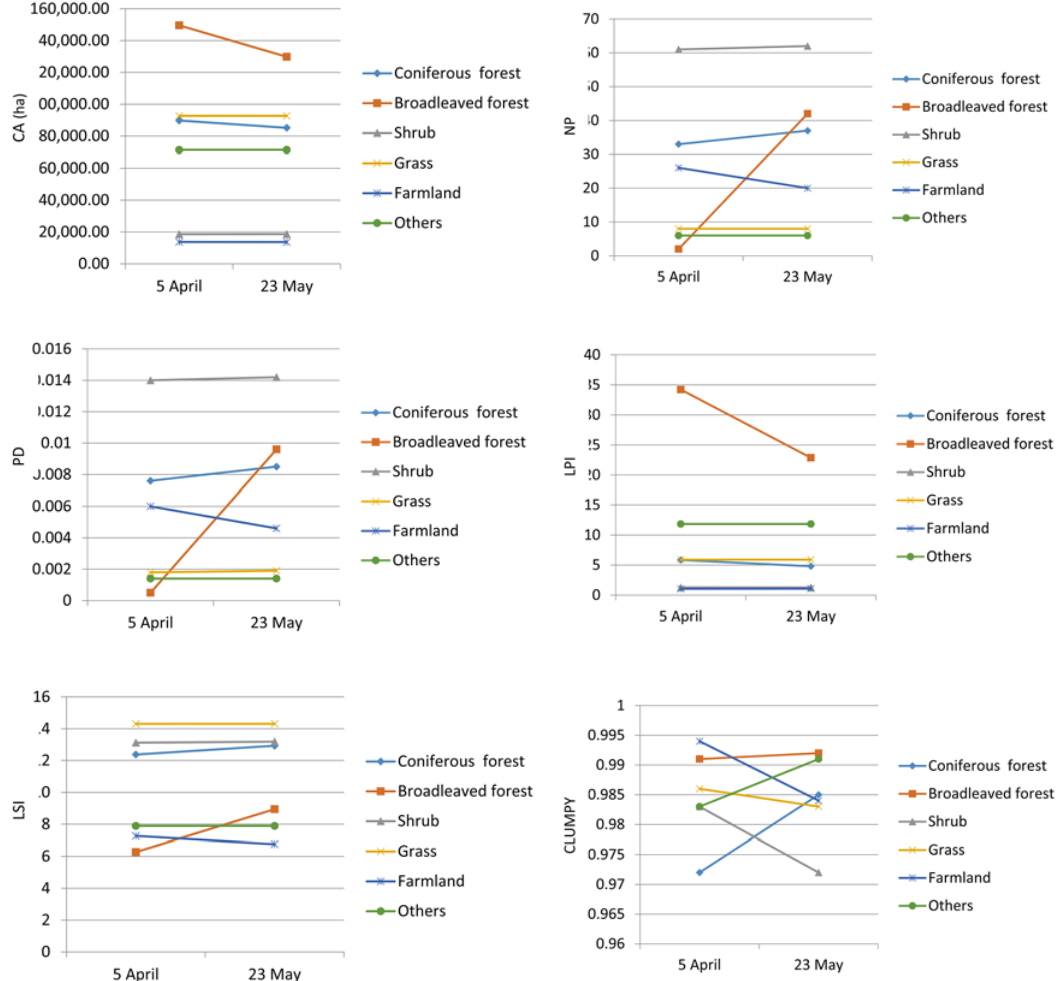
Figure 3. Spatial heterogeneity change of each vegetation type at class level as quantified by landscape metrics at the corresponding level.